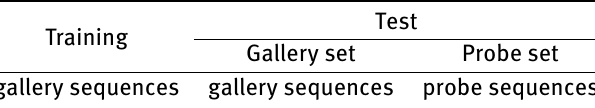
Table 2: Experimental design on OU-ISIR-LP